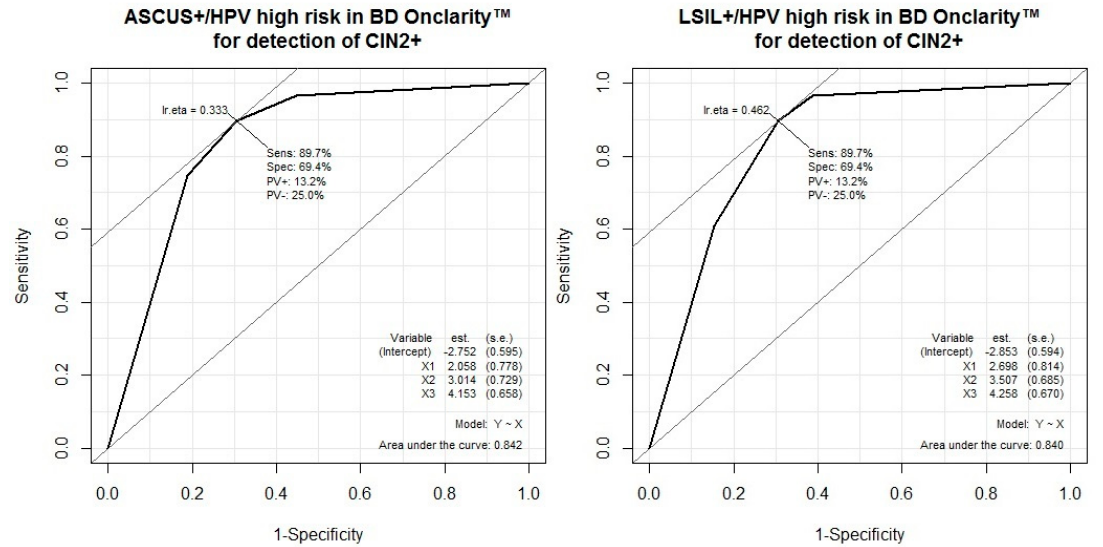
Figure 2. ROC curve of cytology and BD Onclarity ™ HPV assay for the detection of CIN2 or worse: The AUC of Cytology (ASCUS or worse) / BD Onclarity ™ HPV assay is 0.842. The AUC of Cytology (LSIL or worse) / BD Onclarity ™ HPV assay is 0.840.